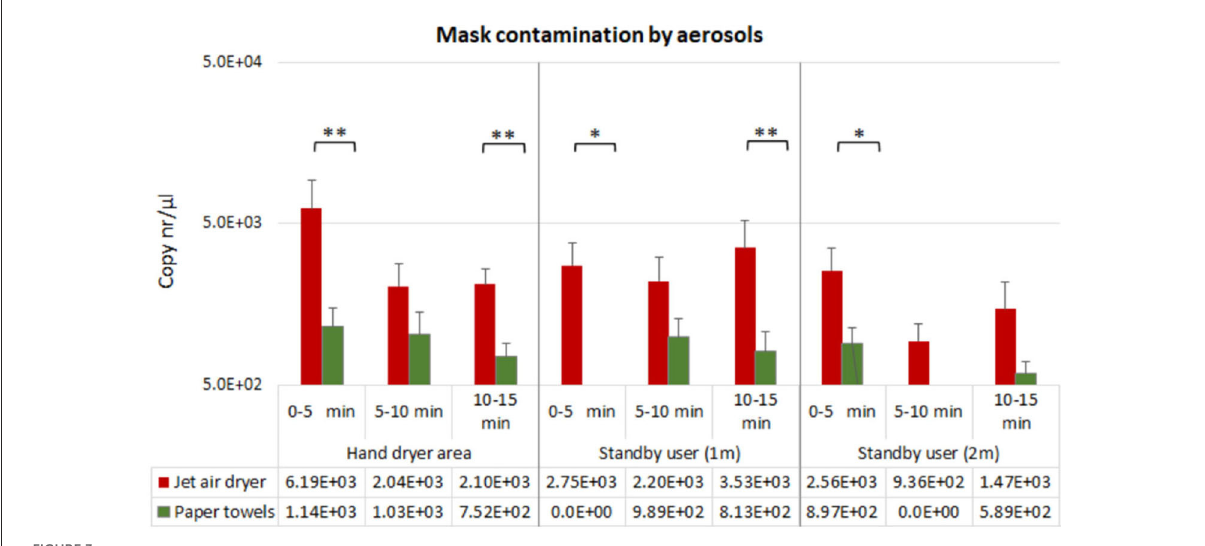
FIGURE3 Mean qPCR results for PR772 bacteriophage recovered from N95 masks at each tested position at 5, 10, and 15min post-hand drying. Bacteriophage recovery is presented as logarithms of gene copy numbers to achieve normal distribution. Single asterisk and double asterisk correspond to * p < 0.1 and ** p < 0.05 significant difference between hand drying methods using the Mann-Whitney test,